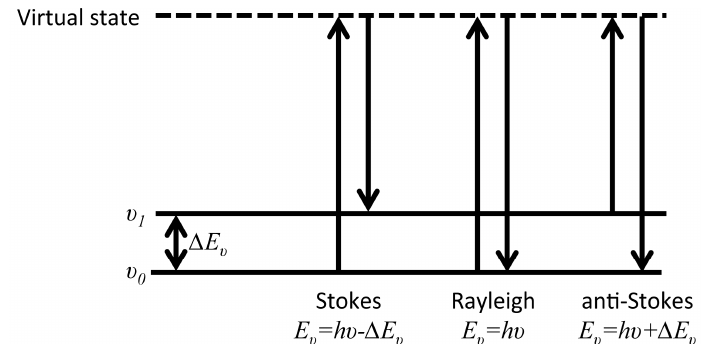
Figure 11. Raman scattering processes. ν 0 and ν 1 represent the ground and first excited vibrational energy states, respectively, with ∆ E v as the energy difference between them.